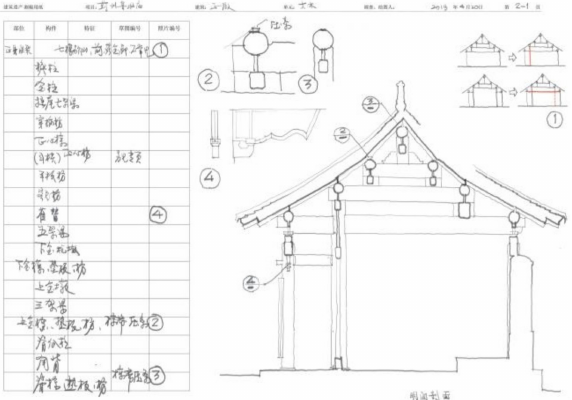
Figure 15. Standard observation notes for the component library.